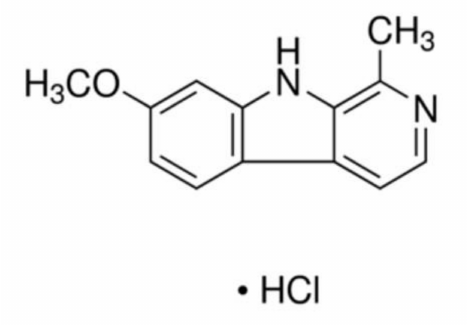
Figure 1. Chemical structure of harmine